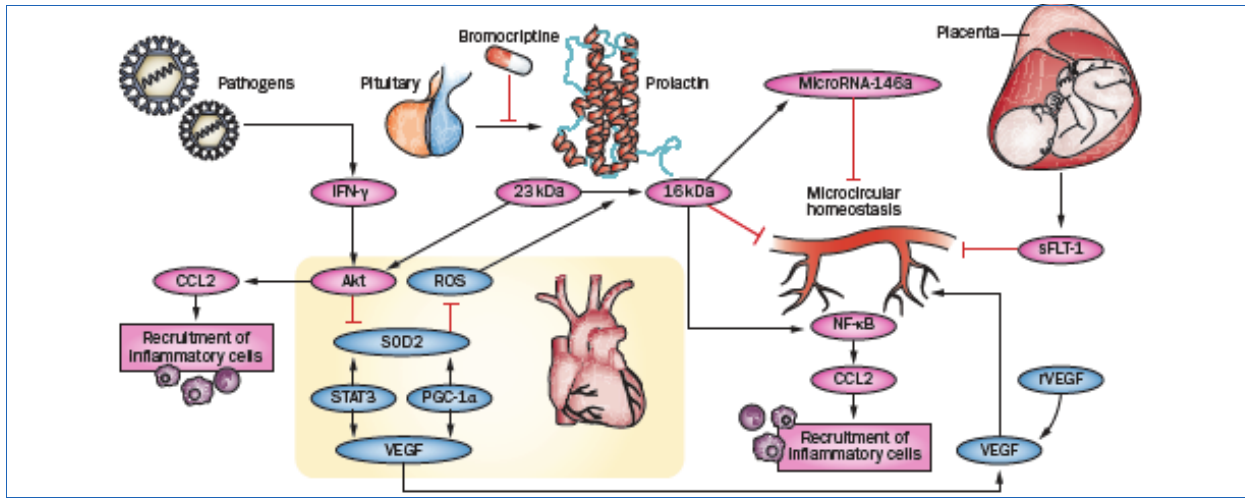
Figure 1. Pathophysiological mechanisms in PPCM